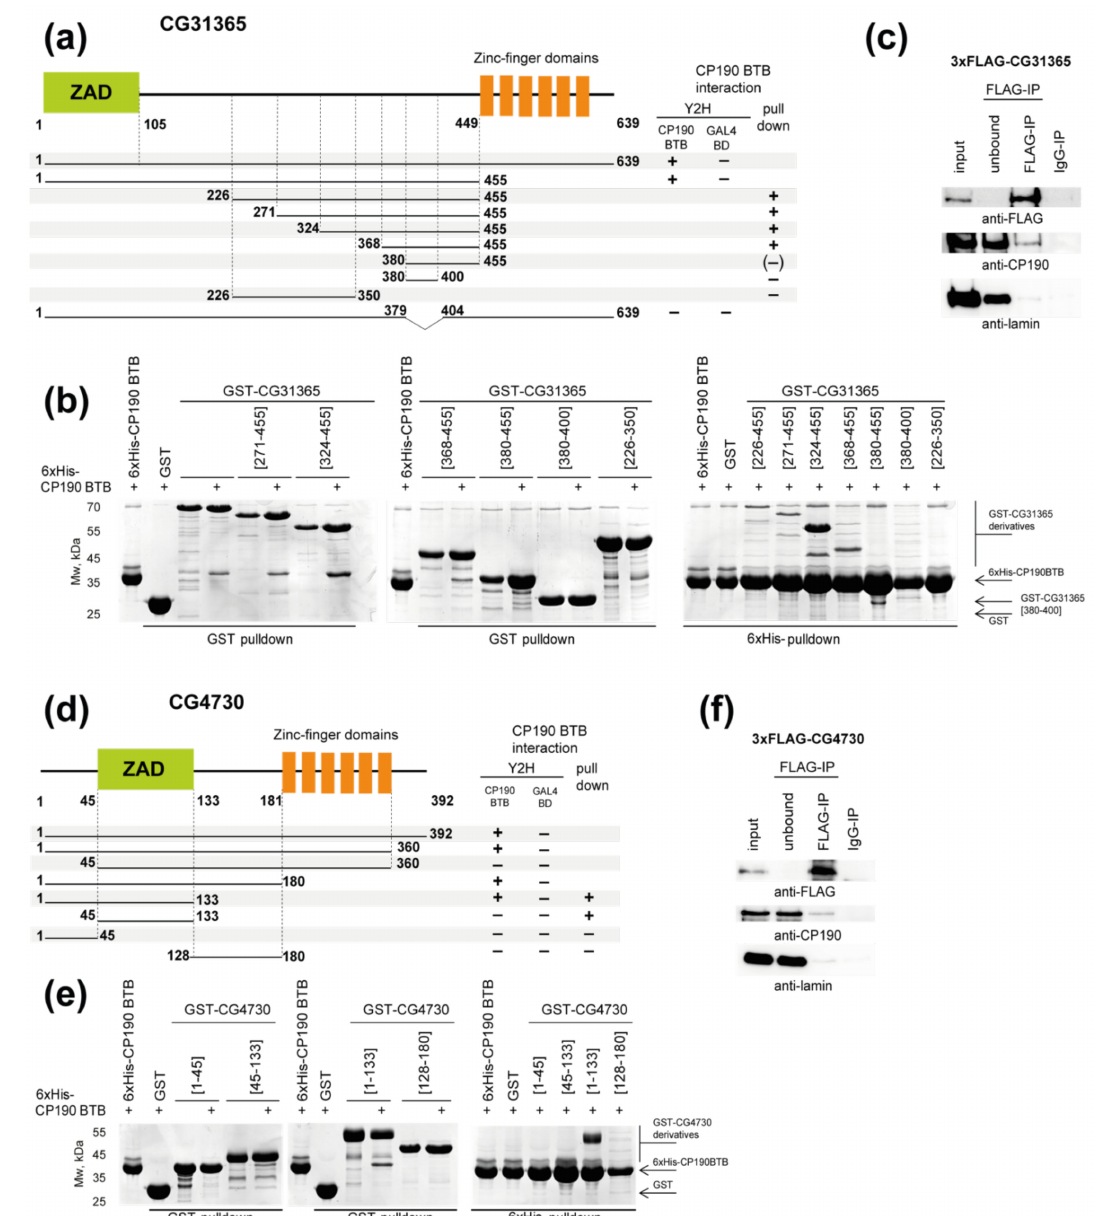
Figure 1. Two new C2H2 proteins that interact with the BTB domain of CP190. ( a ) Summary of the mapping of the interaction between CG31365 and CP190 proteins in pull-down and yeast two-hybrid (Y2H) assays. An uncertain interaction is shown in brackets. For Y2H, different fragments of CG31365 were fused with the GAL4 activation domain and tested for interaction with the CP190 BTB domain fused to the GAL4 DNA-binding domain (GAL4 BD). GAL4 BD serves as the negative control. The growth assay yeast plates are shown in Supplementary Materials Figure S2. ( b ) Mapping of the interaction between CG31365 and CP190 proteins using pull-down assays. The uncropped images are shown in the Supplementary Materials Figure S3. ( c ) Co-immunoprecipitation of CP190 and CG31365 tagged with FLAG in extracts from Drosophila S2 cells. Total extracts were immunoprecipitated with FLAG antibodies. The immunoprecipitates (IPs) were analyzed by Western blotting. The uncropped images are shown in Supplementary Materials Figure S1. ( d ) Summary of the mapping of the interaction between CG4730 and CP190 proteins in pull-down and Y2H assays. Designations are the same as in panel ( a ). ( e ) Mapping of the interaction between CG4730 and CP190 proteins using pull-down assays. The uncropped images are shown in the Supplementary Materials Figure S3. ( f ) Co-immunoprecipitation of CP190 and CG4730 tagged with FLAG in extracts from Drosophila S2 cells. Total extracts were immunoprecipitated with FLAG antibodies. The immunoprecipitates (IPs) were analyzed by Western blotting. The uncropped images are shown in the Supplementary Materials Figure